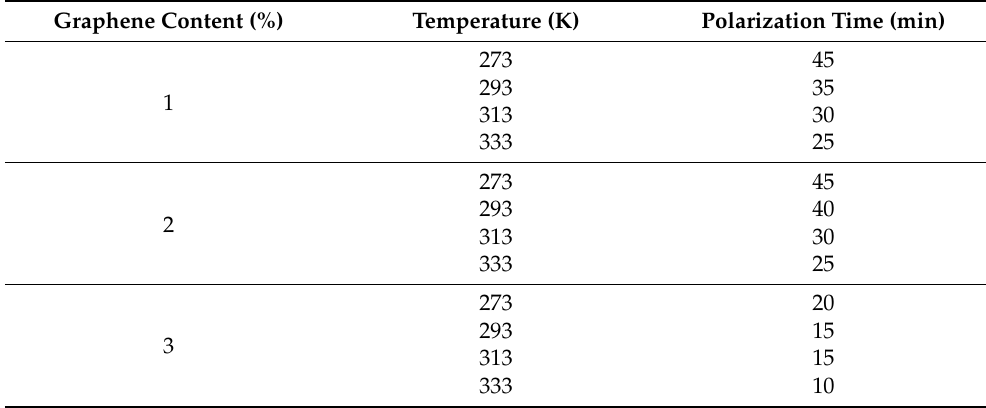
Table 8. Polarization time of specimens with different graphene contents after freeze–thaw at different